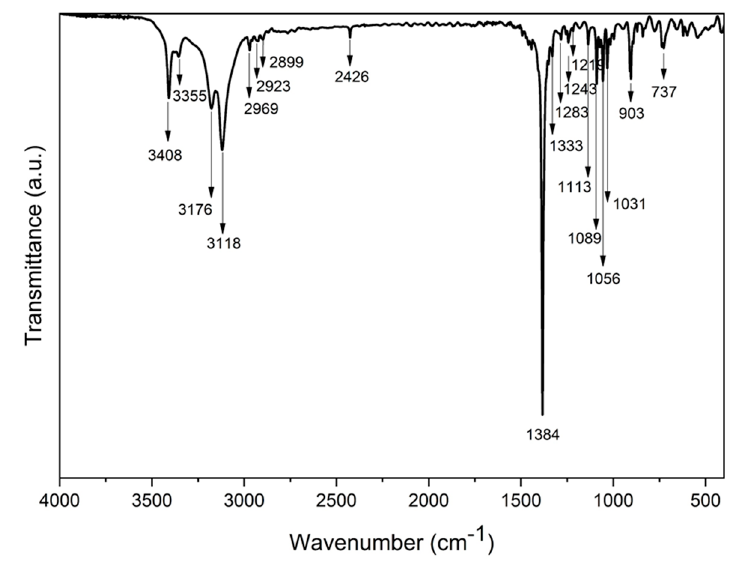
Figure 4. Fourier transformed infrared spectroscopy (FTIR) spectrum of the Ni-TEA complex.